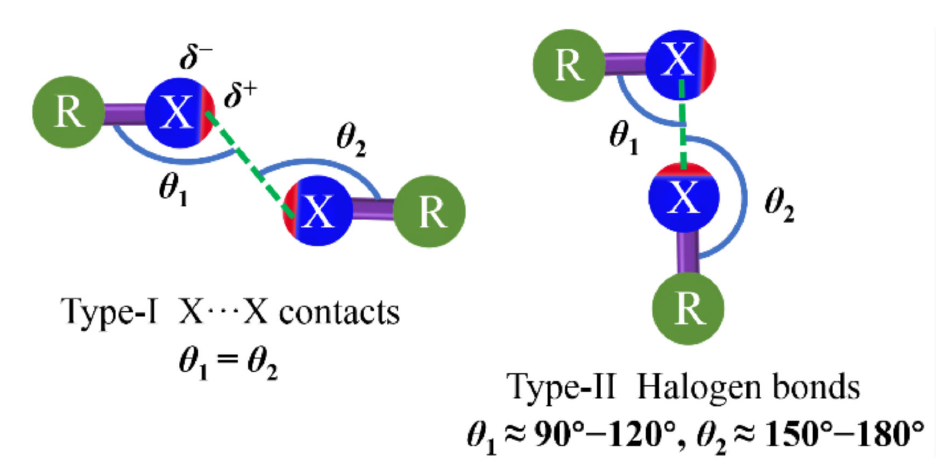
Figure2. Structuralschemefortype-I( left )andtype-II( right )halogen ··· halogeninteractions. X =